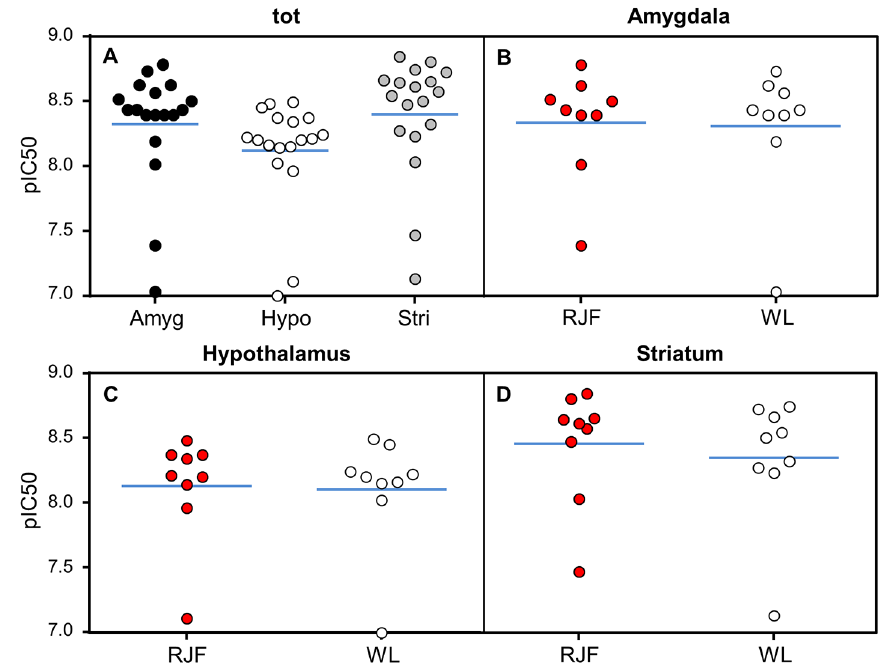
Figure 5. ADRA2C abundance from receptor binding assays. A) Receptor abundance in 3 brain regions with all animals pooled. Abundance in amygdala (B), hypothalamus (C) and striatum (D). The line indicate the mean value and dots indicate individual data points.